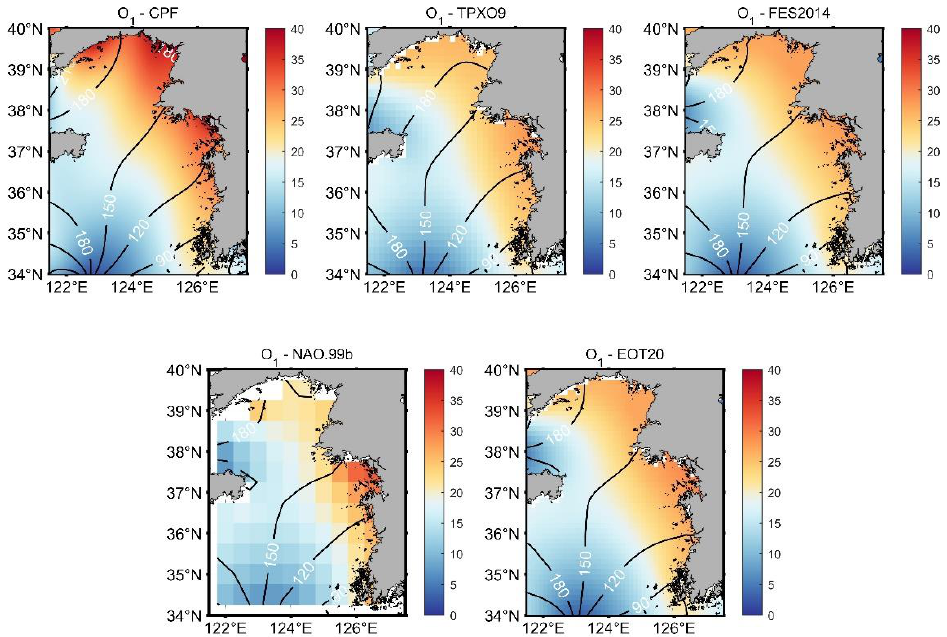
Figure 8. The cotidal charts of the O 1 constituent from the CPF method and the TPXO9, FES2014, NAO.99b and EOT20 models (unit: cm).